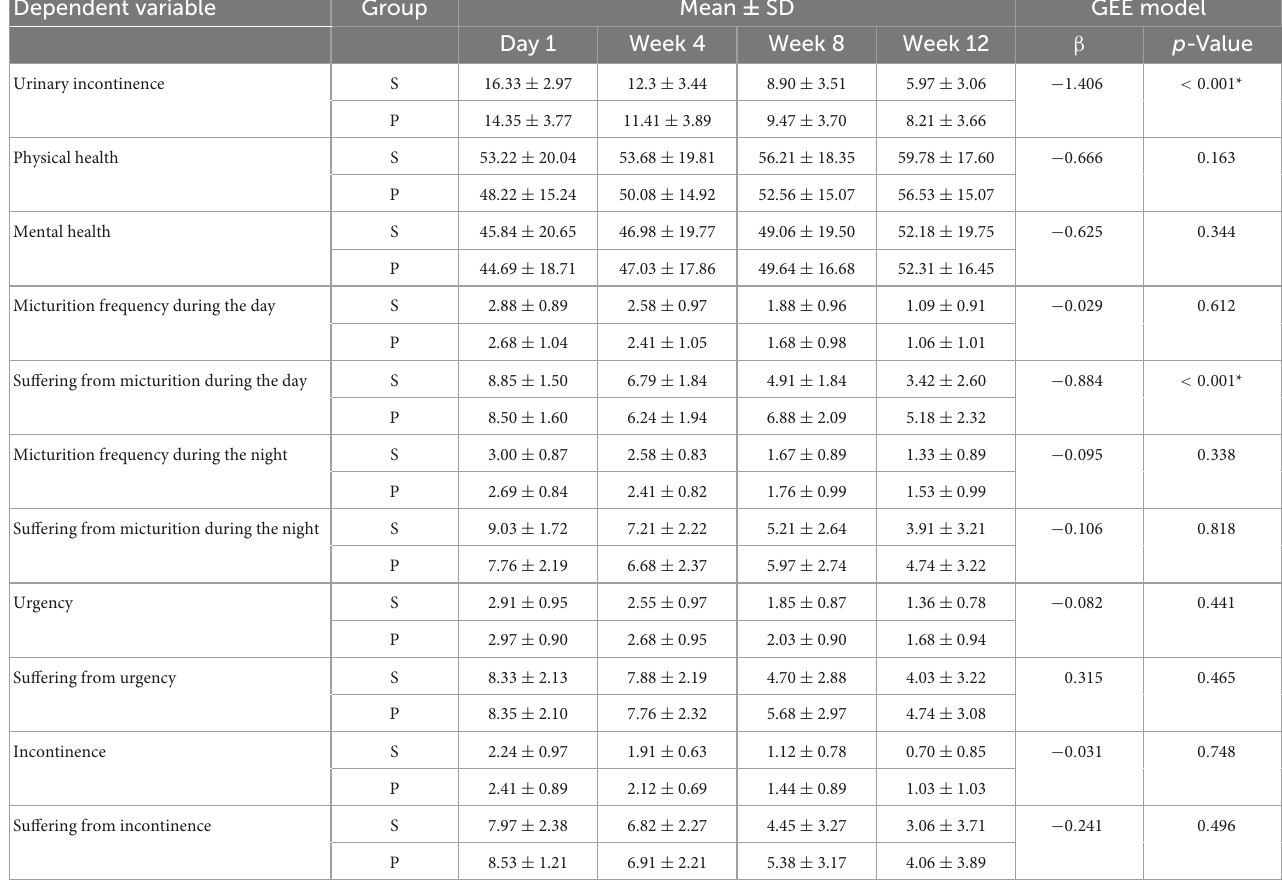
TABLE 1 The result of generalized equation estimation (GEE) model for trend of changes in each factor over 3 months follow-up. Dependent